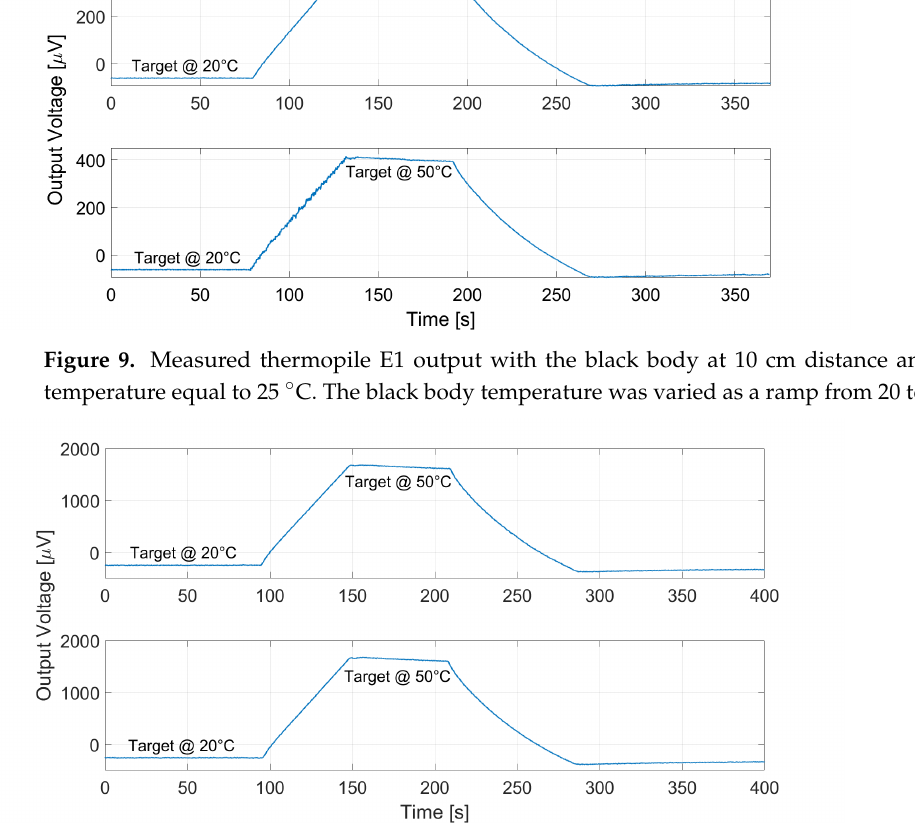
Figure 10. Measured thermopile E2 output with the black body at 10 cm distance and ambient temperature equal to 25 ◦ C. The black body temperature was varied as a ramp from 20 to 50 ◦ C.